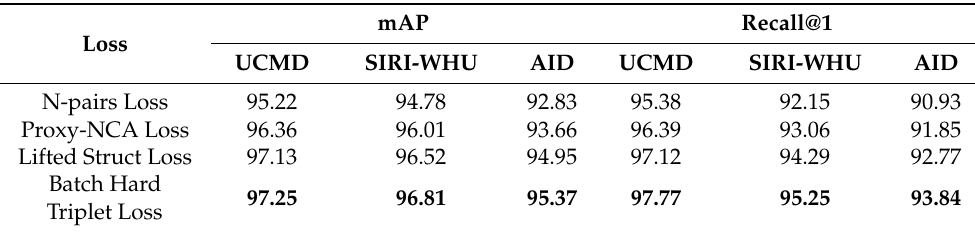
Table 3. The evaluation results of mAP (%) and R@1 (%) on UCMD, SIRI-WHU, and AID compared with the other structure